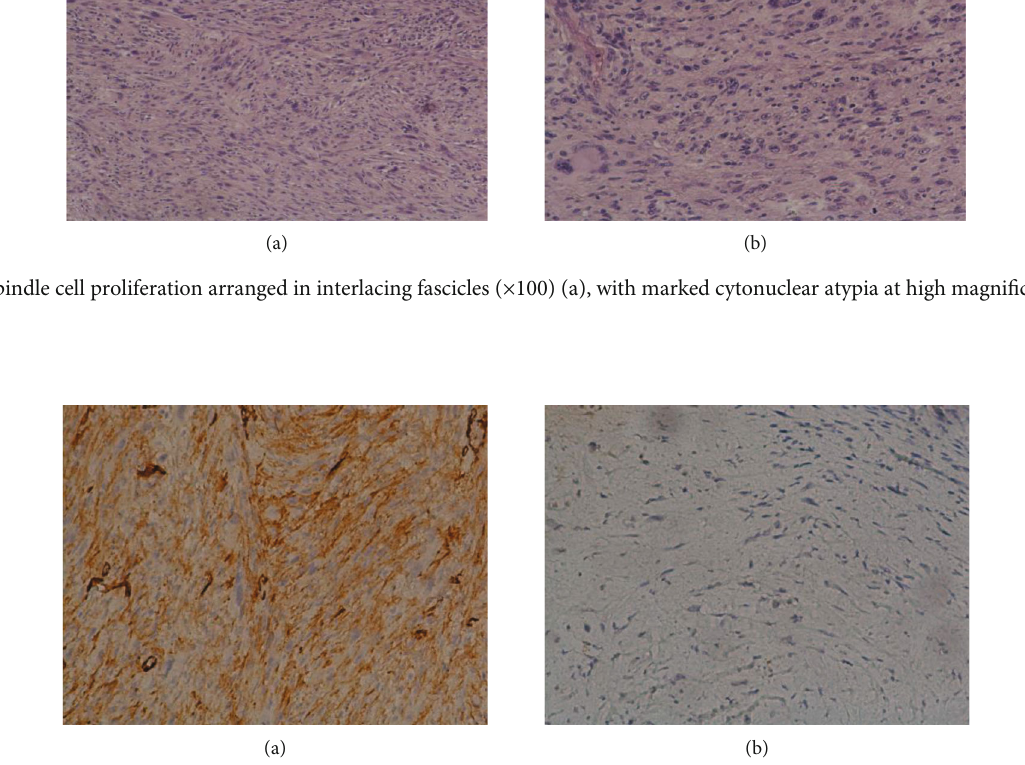
Figure 2: Immunohistochemistry fi ndings showing positive staining for caldesmon (a) and myogenin (b) negativity. Original magni fi cation × 200.